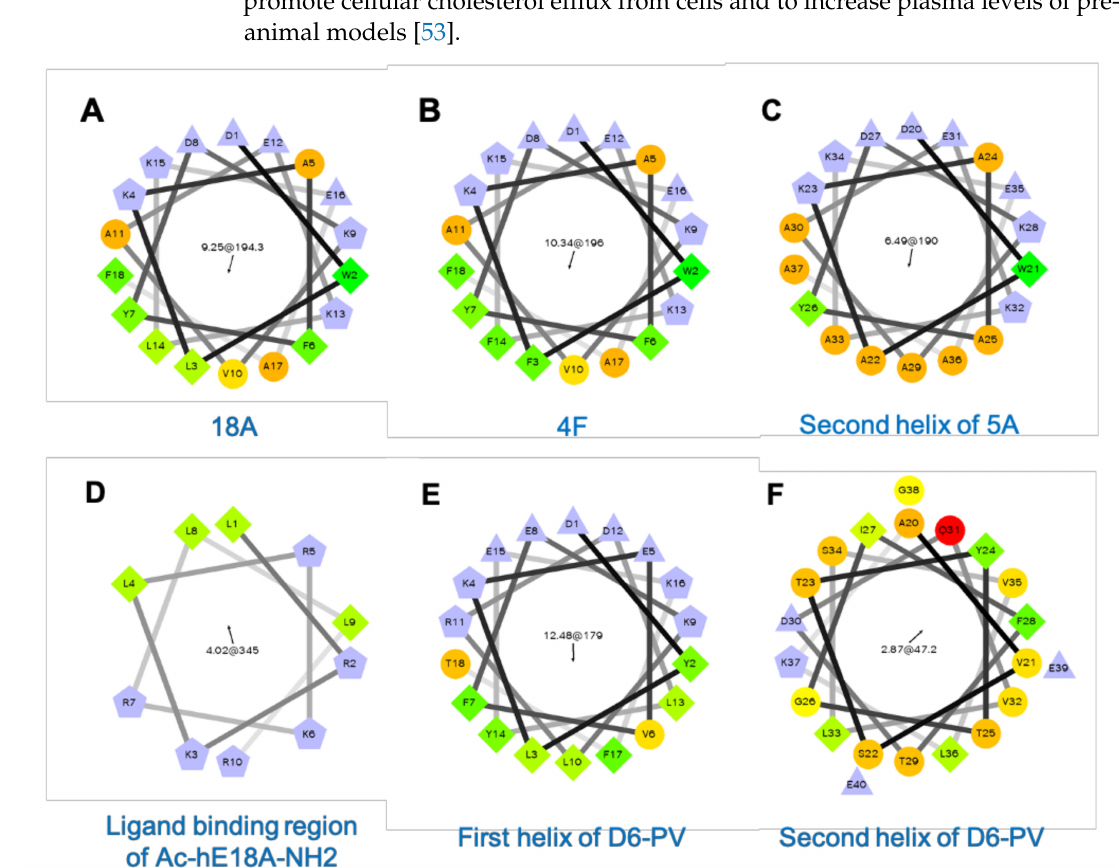
Figure 2. Helical wheel plots of apolipoprotein mimetic peptides: ( A ) 18A, ( B ) 4F, ( C ) Second helix of 5A, ( D ) ligand-binding region of Ac-hE18A-NH2, ( E ) First helix of D6PV, ( F ) Second helix of D6PV. First number in the center of the helical wheel plot indicates hydrophobic moment and the second number with a black arrow shows an angle of the hydrophobic moment. Purple: charged residues, Green: hydrophobic residues, Orange: polar or partially hydrophobic amino